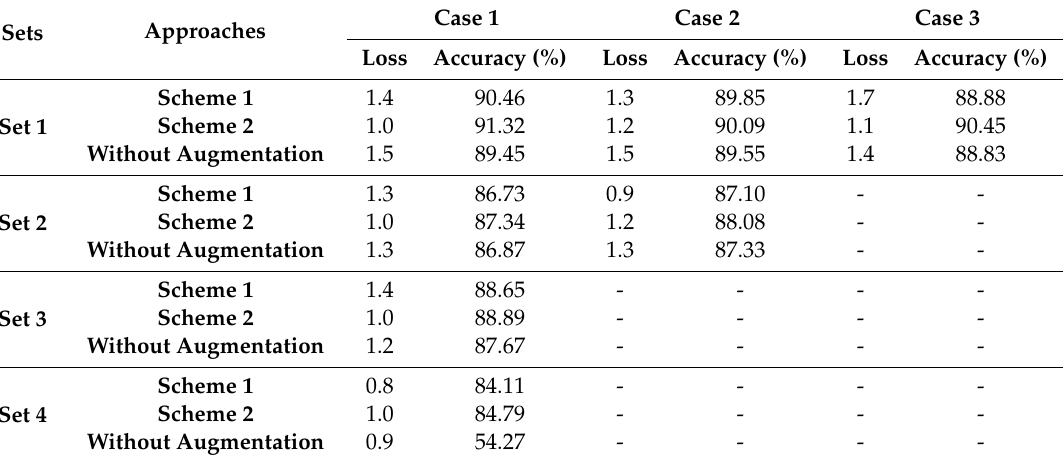
Table 2. Lab simulation results for accuracy and